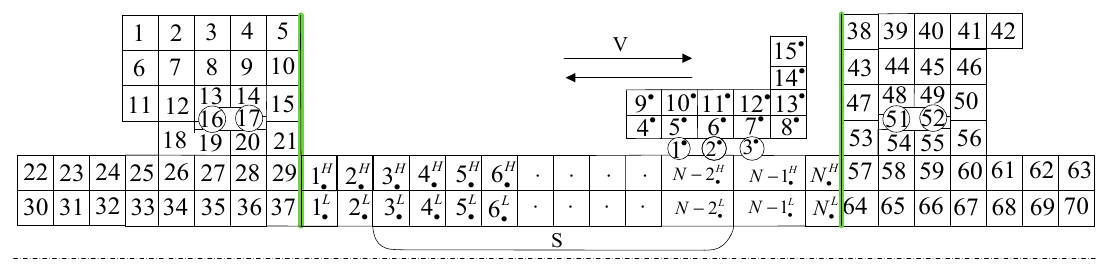
Figure 3. Thermal network arrangement of the ball screw system.